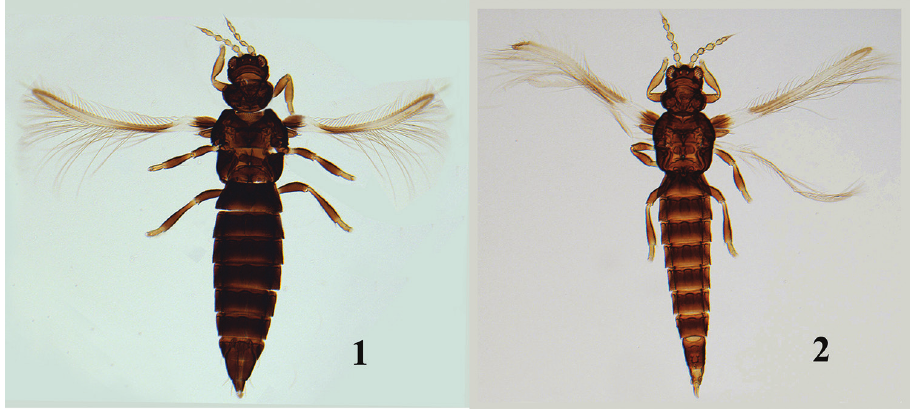
Figures 1–2. Helionothrips lushanensis sp. n. 1 female 2